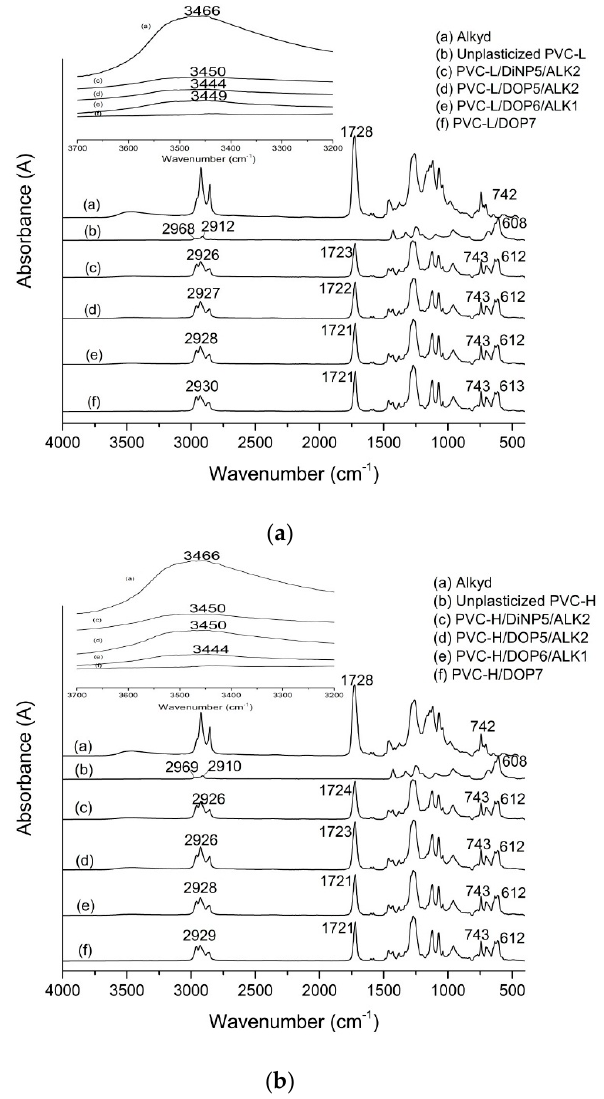
Figure 2. Effect of palm oil-based alkyd on ATR-FTIR spectra of ( a ) plasticized PVC-L blends; and ( b ) plasticized PVC-H blends.